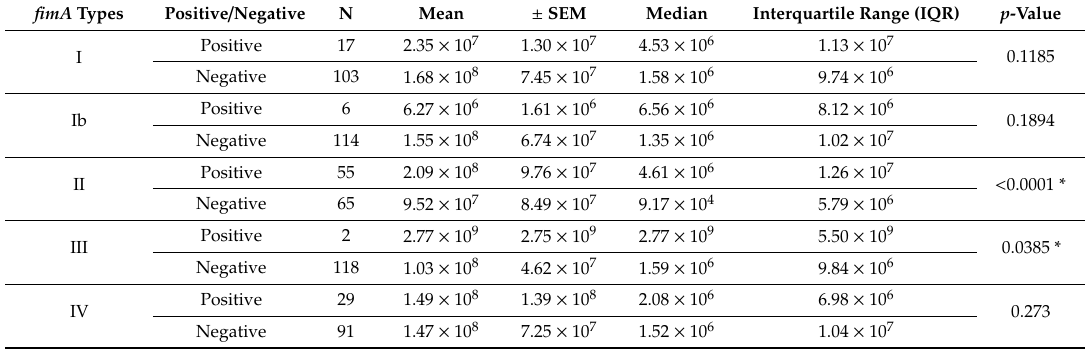
Table 4. Associationof fimA genotypeswiththequantityof P.gingivalis inpatientswithchronicperiodontitis. fimA